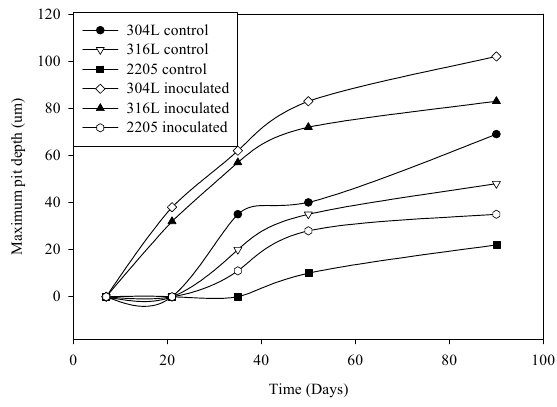
Fig. 8 Scanning electron micrograph showing pits on stainless steel 304L exposed to inoculated Baar's media in 50 day's immersion test.